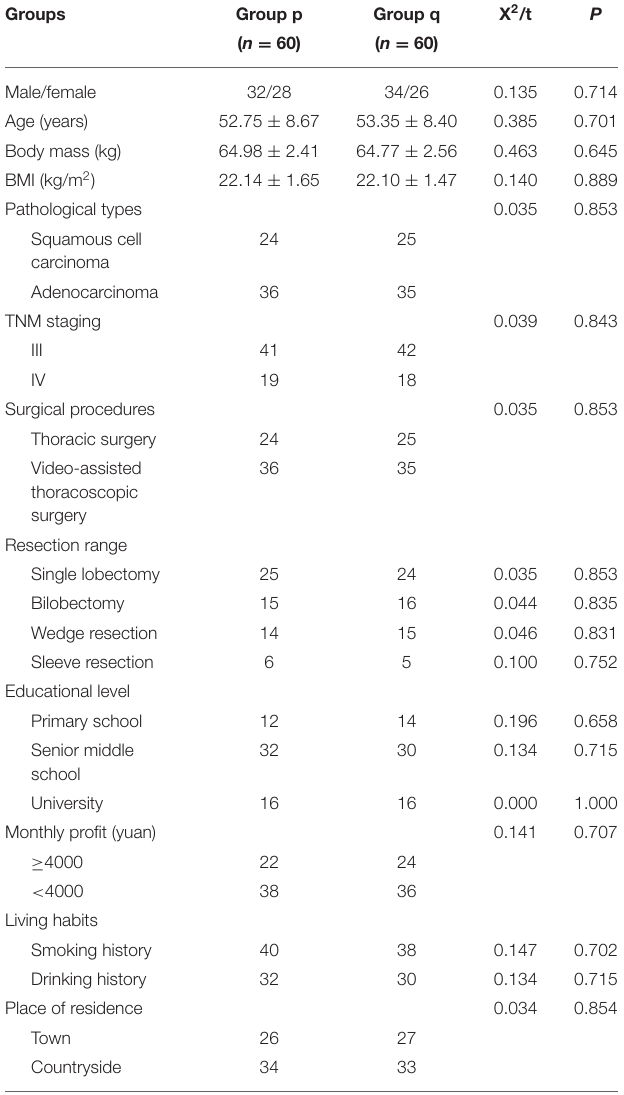
TABLE 1 | Comparison of patients’ general information.